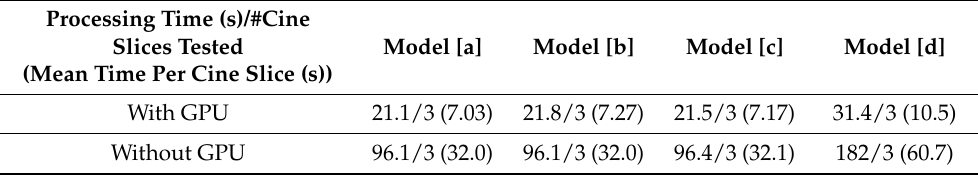
Table 5. Processing time of different models with or without the GPU. The time here is inclusive of data loading, model loading and